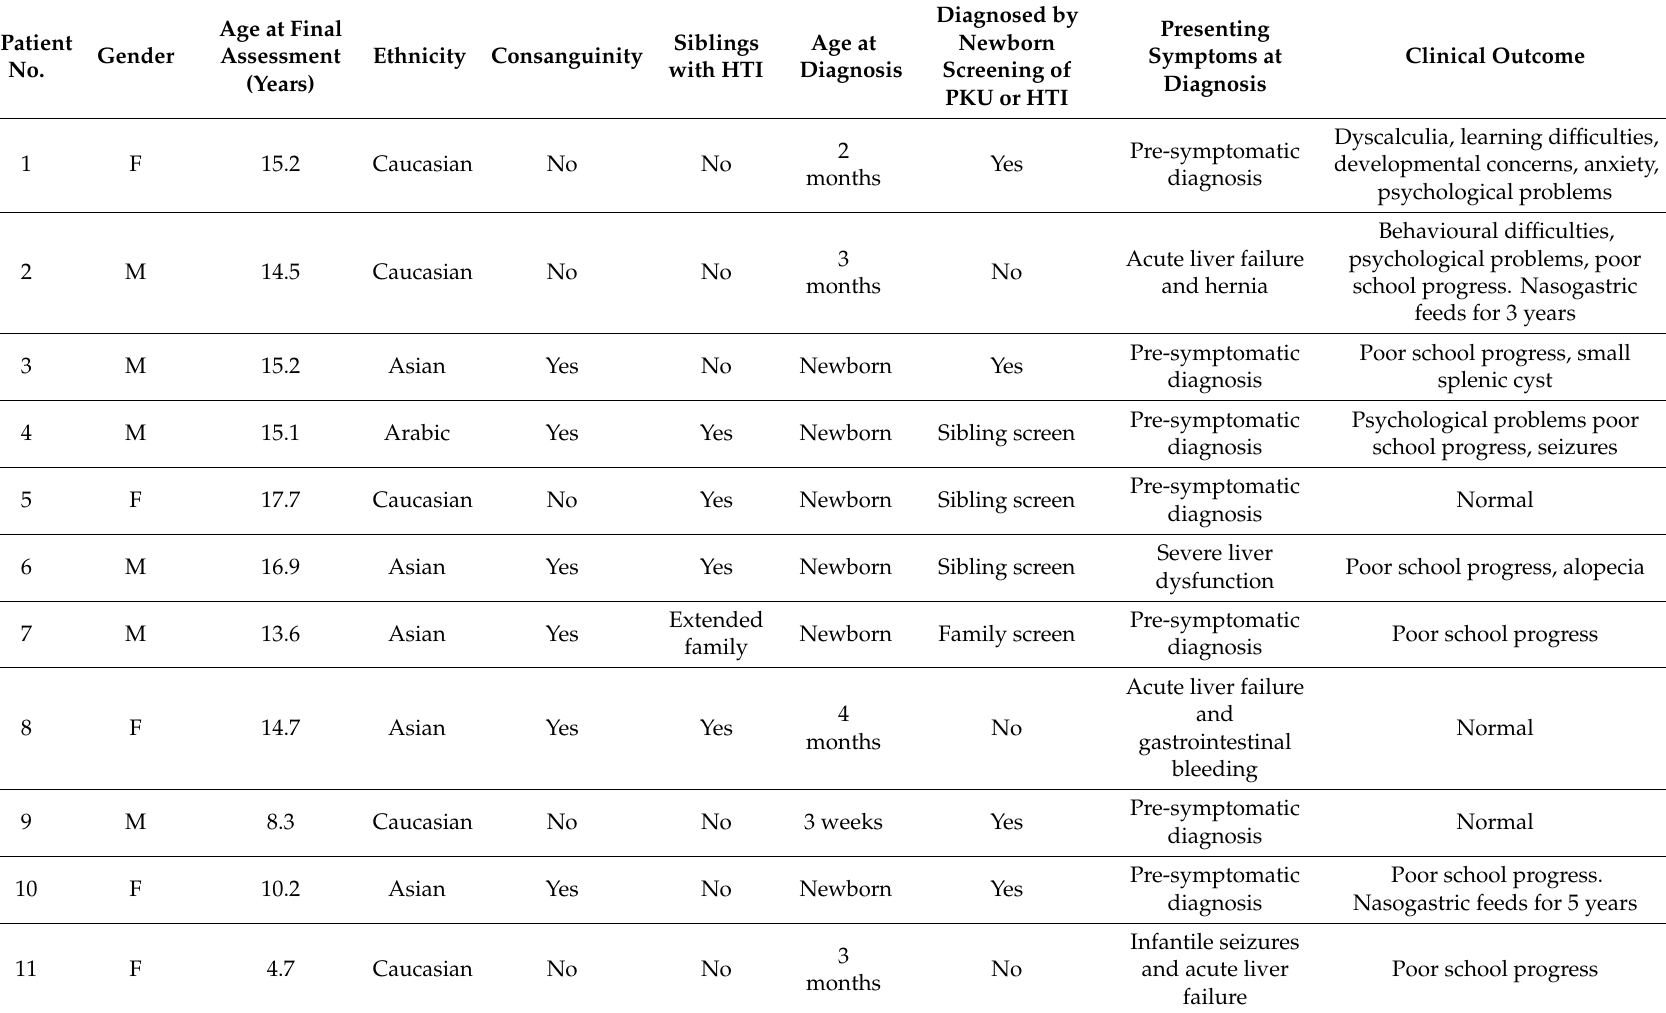
Table 1. Demographic information and clinical characteristics of HTI